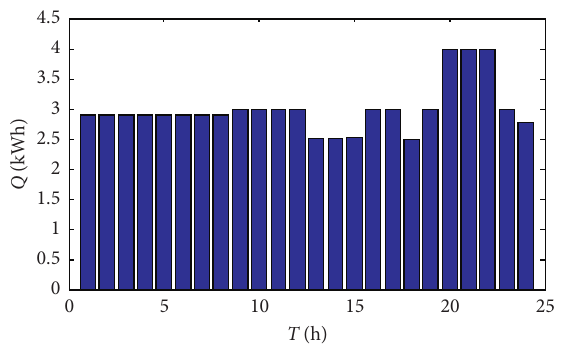
Figure 3: Load under smart use of Table 2: Comparison of the convergence speed and accuracy of the algorithm. Algorithm